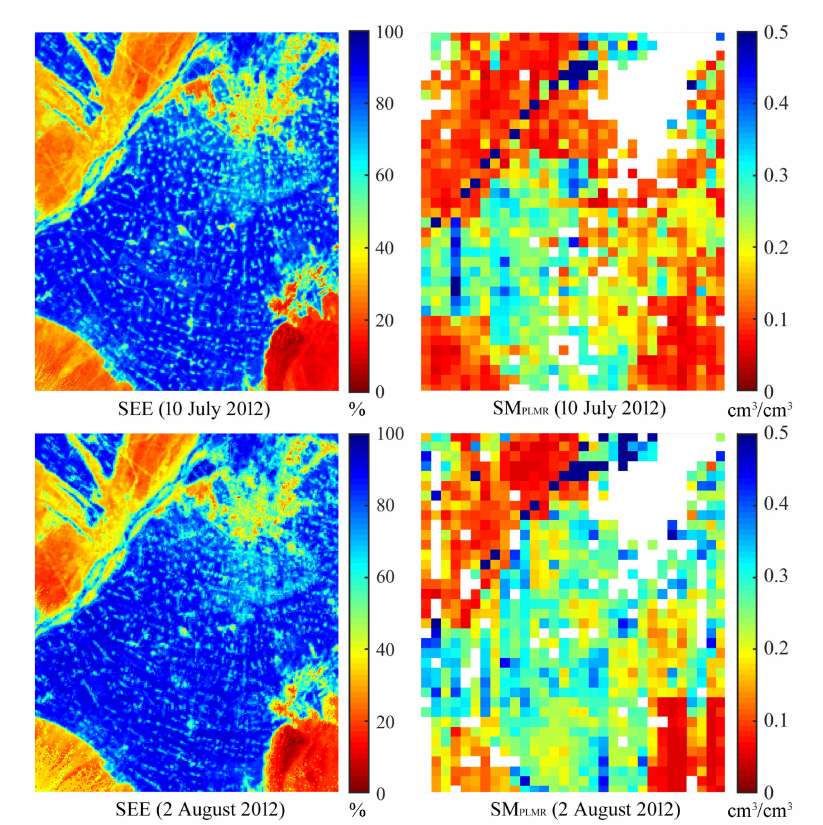
Figure 7. Comparison of the SEE and PLMR soil moisture products (SM PLMR ) on 10 July and 2 August 2012.